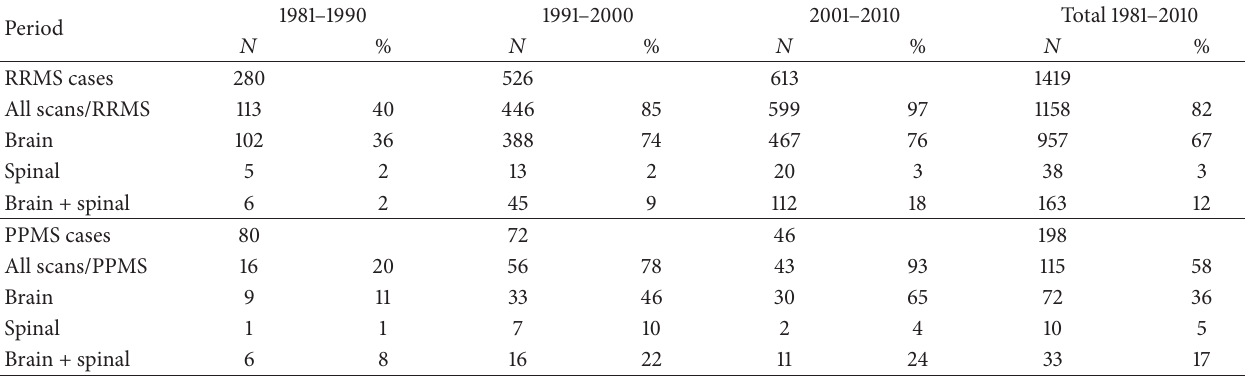
Table 2: Use of MRI scans in the diagnostics of MS by disease courses (RRMS and PPMS) in the study cohort diagnosed from 1981 to 2010.